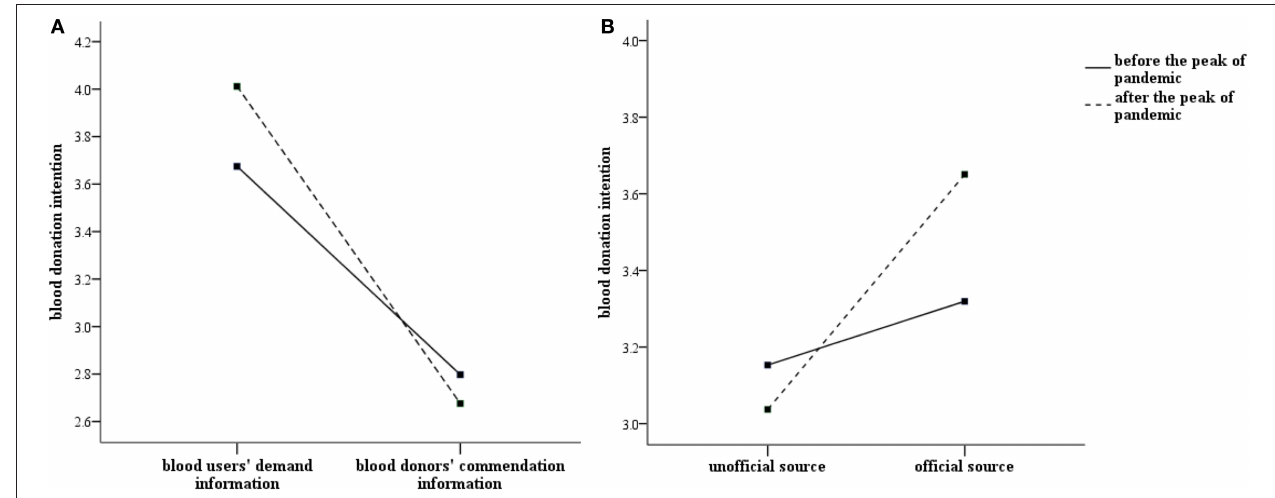
FIGURE 1 | Interaction effects of information content and pandemic on blood donation intention (A) ; Interaction effects of information source and pandemic on blood donation intention (B)